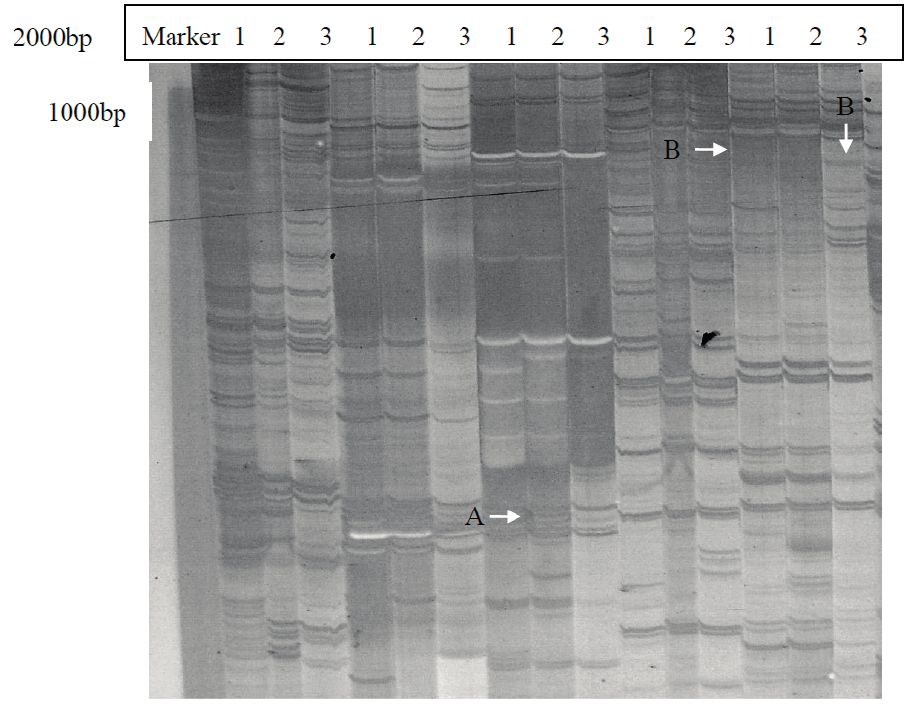
Figure 3. Differentially expressed cDNA fragments on a silver-stained cDNA-AFLP PAGE gel. (1) Primary SAMs of Chinese fir No. 020 that start elongation (are initiating AMs). The materials were obtained on 6 May; (2) Primary SAMs of Chinese fir No. 020 in un-elongation (before AMs initiation). The materials were obtained on 15 April 2009; (3) Primary SAMs of Chinese fir mutant “Dugansha”. The materials were obtained on 6 May 2009. Fragment “A”: Differentially expressed cDNA fragment that potentially regulate shoot branching positively Fragment “B”: Differentially expressed cDNA fragments that potentially regulate shoot branching